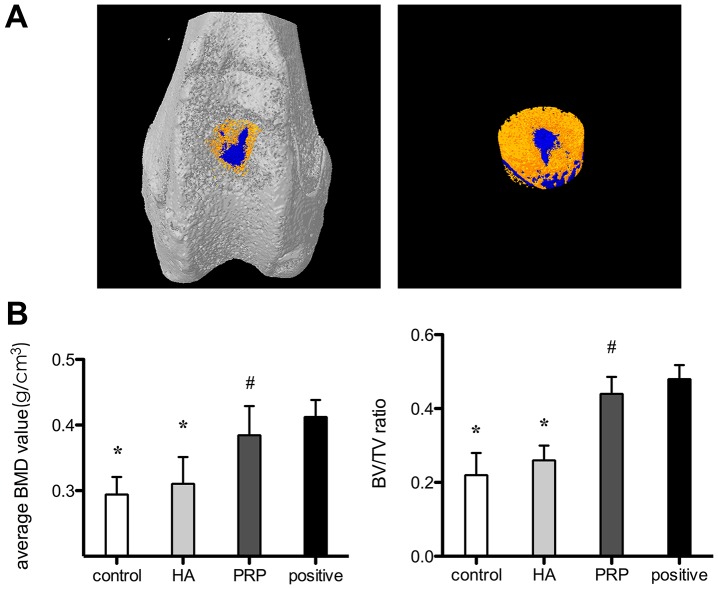
The results of micro-CT test.(A).Assessment of subchondral bone restoration in PRP group. Bright yellow represents regenerated bone and blue for tissue with lower density, such as fibrous tissue. (B).Comparison of bone mineral density(BMD) and BV/TV between the three groups and normal bone tissue(positive). *denotes statistically significant difference compared with positive group(p<0.01) and PRP group(p<0.01); #denotes none statistically significant difference compared with the positive group(p>0.05).